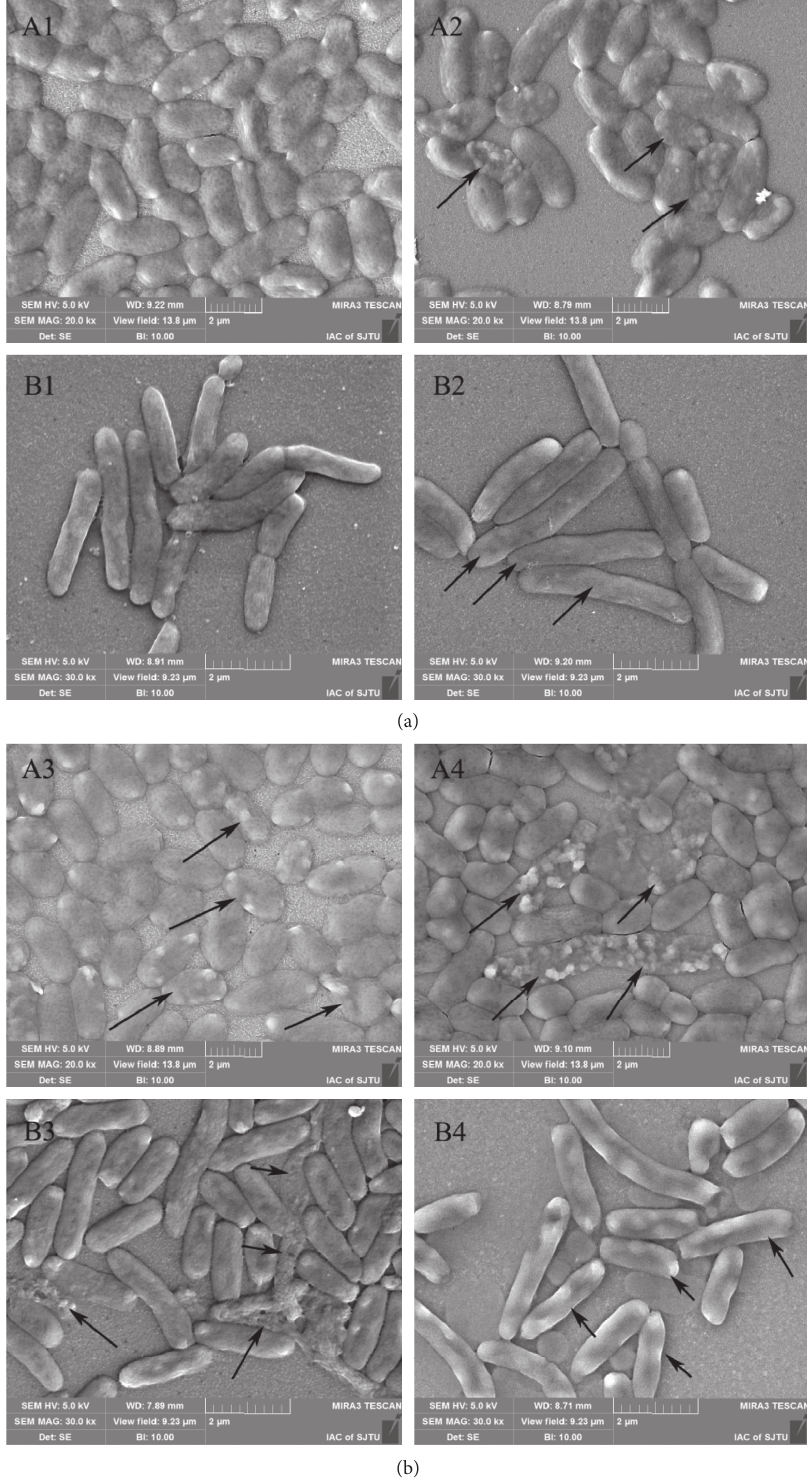
Figure 5: Scanning electron micrographs of P. fluorescens (a) and S. putrefaciens (b) (A1–B1, control; A2–B2, addition of 1 × MIC daphnetin; A3–B3, addition of 2 × MIC daphnetin; A4–B4, addition of 4 × MIC